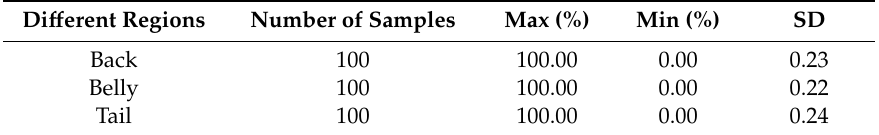
Table 1. The statistical data of the scaling rate in di ff erent regions of the samples. SD: standard